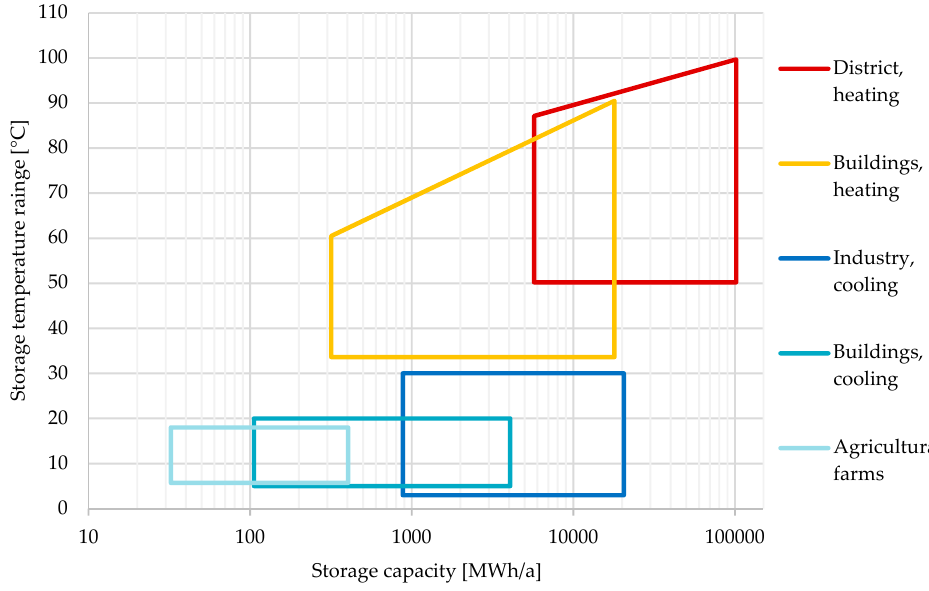
Figure 1. Storage capacity and temperature ranges for different sectors according to the VDI [13].